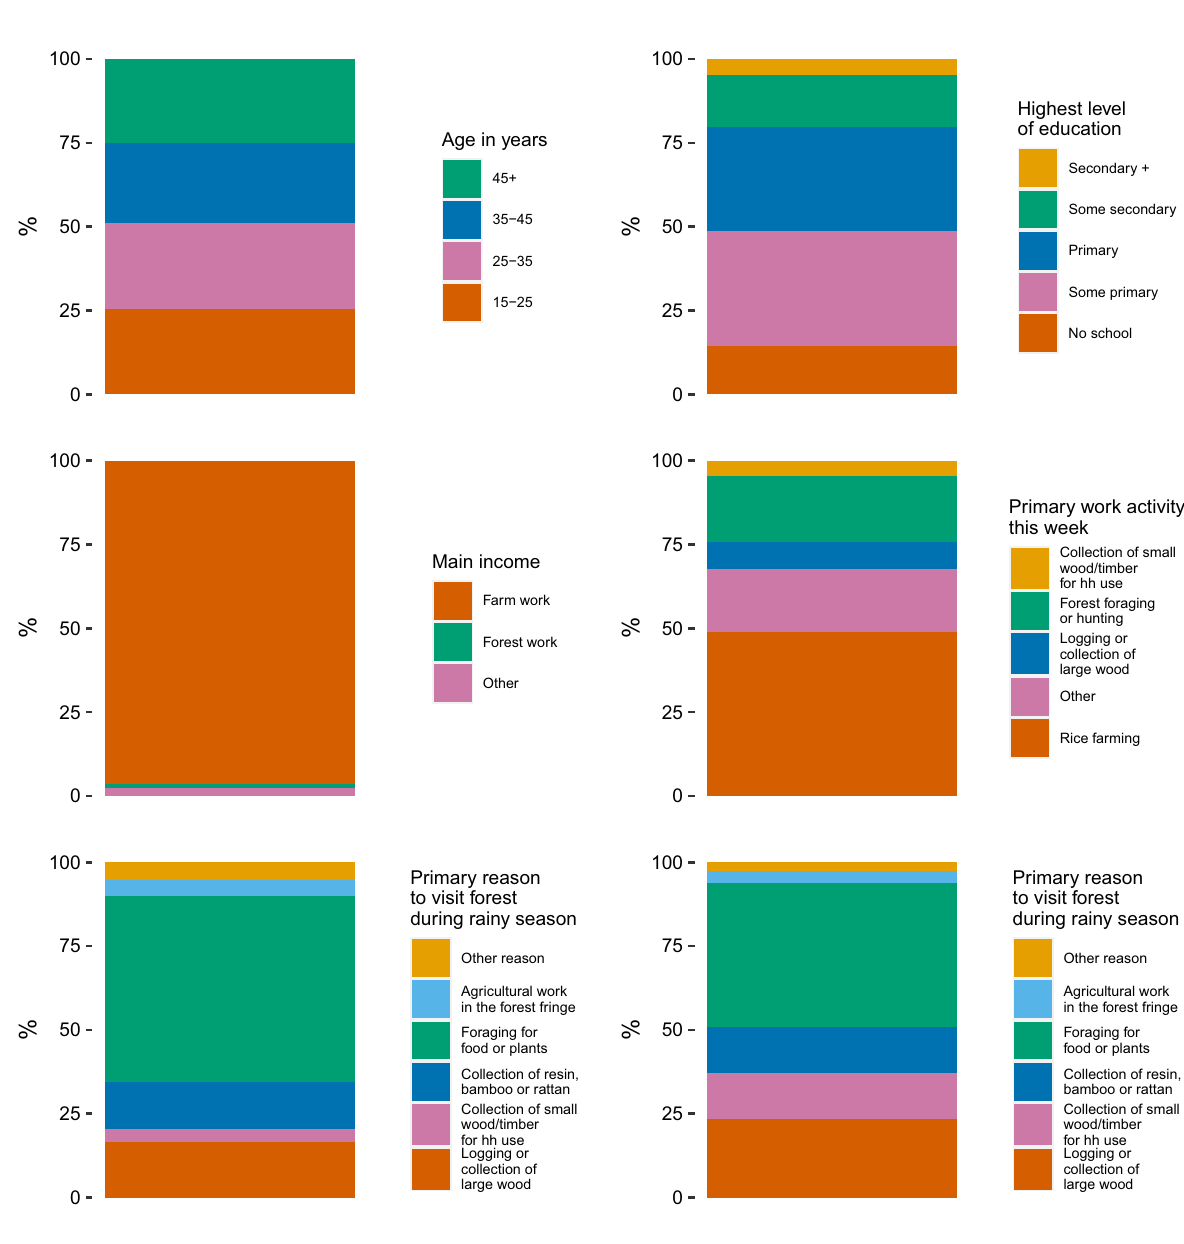
Figure 2. Demographics of FTAT HRP: age, education, income, work activity, reasons to visit the forest of HRP individuals enrolled in FTAT